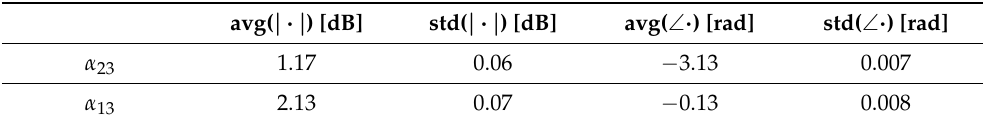
Table 3. Statistical indexes of the amplitude and phase of the α -matrix coefficients on the 50 snapshots of the single experimental calibration